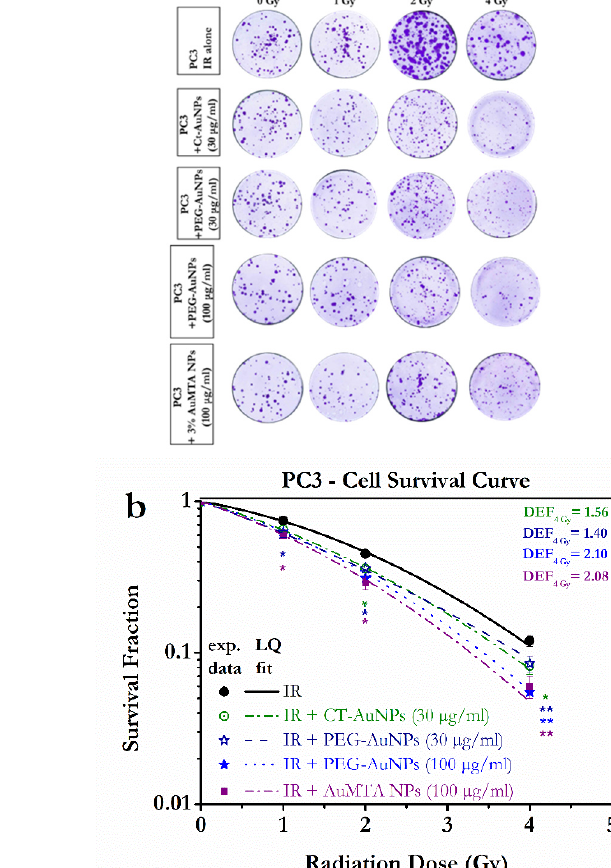
Figure 7. Radiosensitization of A549 ( a ) and PC3 cells ( b ) by gold nanoparticles. ( a , b ) represent the normalized survival curves for A549 and PC3 cells irradiated with 320 KVp X-rays (denoted ‘IR’ for the untreated groups). Data were fitted based on the linear quadratic (LQ) model. The DEFs for the dose of 4 Gy are also presented in the graphs. Statistical significance was determined using Student t test: * p ≤ 0.05, ** p ≤ 0.01. Upper images show indicatively the colony formation for the untreated A549 and PC3 cells and for the A549 and PC3 cells treated with AuNPs, at radiation doses 1.2 and 4